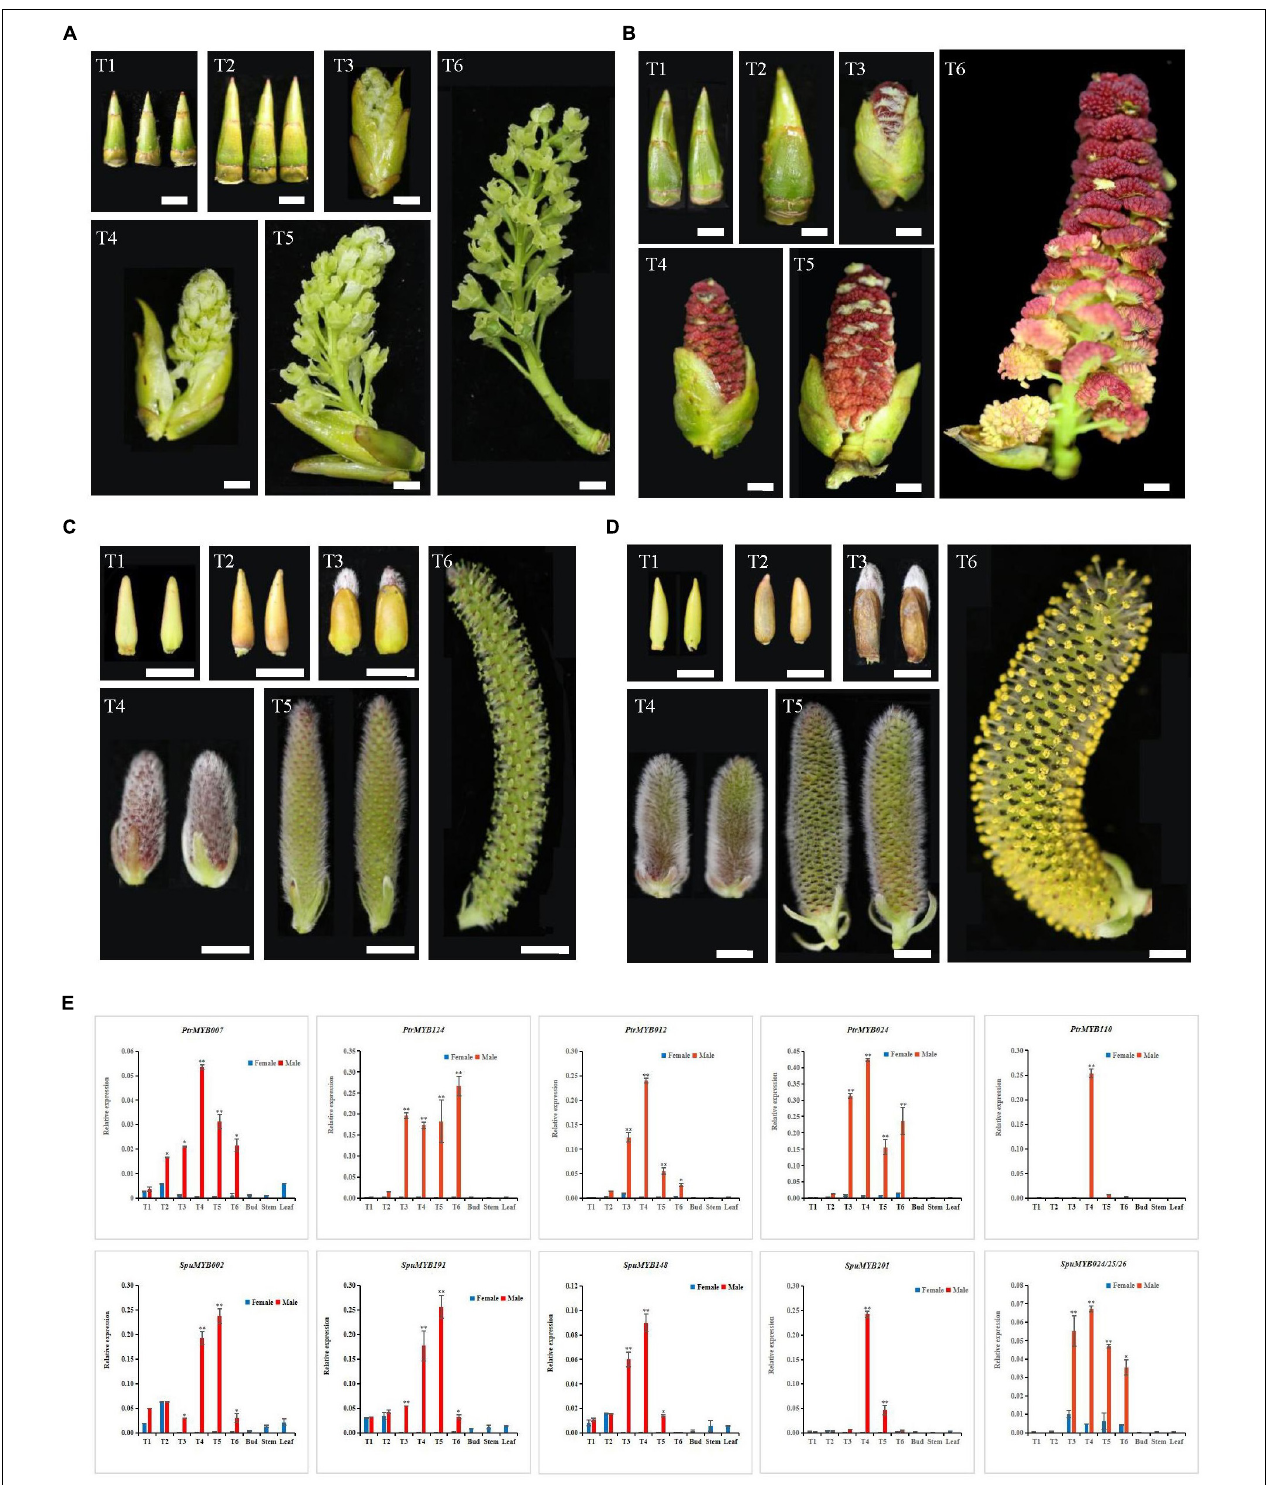
FIGURE 5 | Determination of the expression profile of GAMYB genes in male and female flower buds by qRT-PCR. (A) The morphology of female flower buds of poplar at developmental stages T1-T6 as defined in the text. (B) The morphology of male flower buds of poplar at developmental stages T1-T6 as defined in the text. (C) The morphology of female flower buds of willow in the developmental stages T1-T6 as defined in the text. (D) The morphology of female flower buds of willow in the developmental stages T1-T6 as defined in the text. (E) The bar graph shows the results of the qRT-PCR analysis of GAMYB genes in different tissues and organs. The displayed value shown is the mean ± SD of three biological replicates (* P < 0.05; ** P < 0.01, two-sided Student’s t -test). Bar = 0.5 mm.